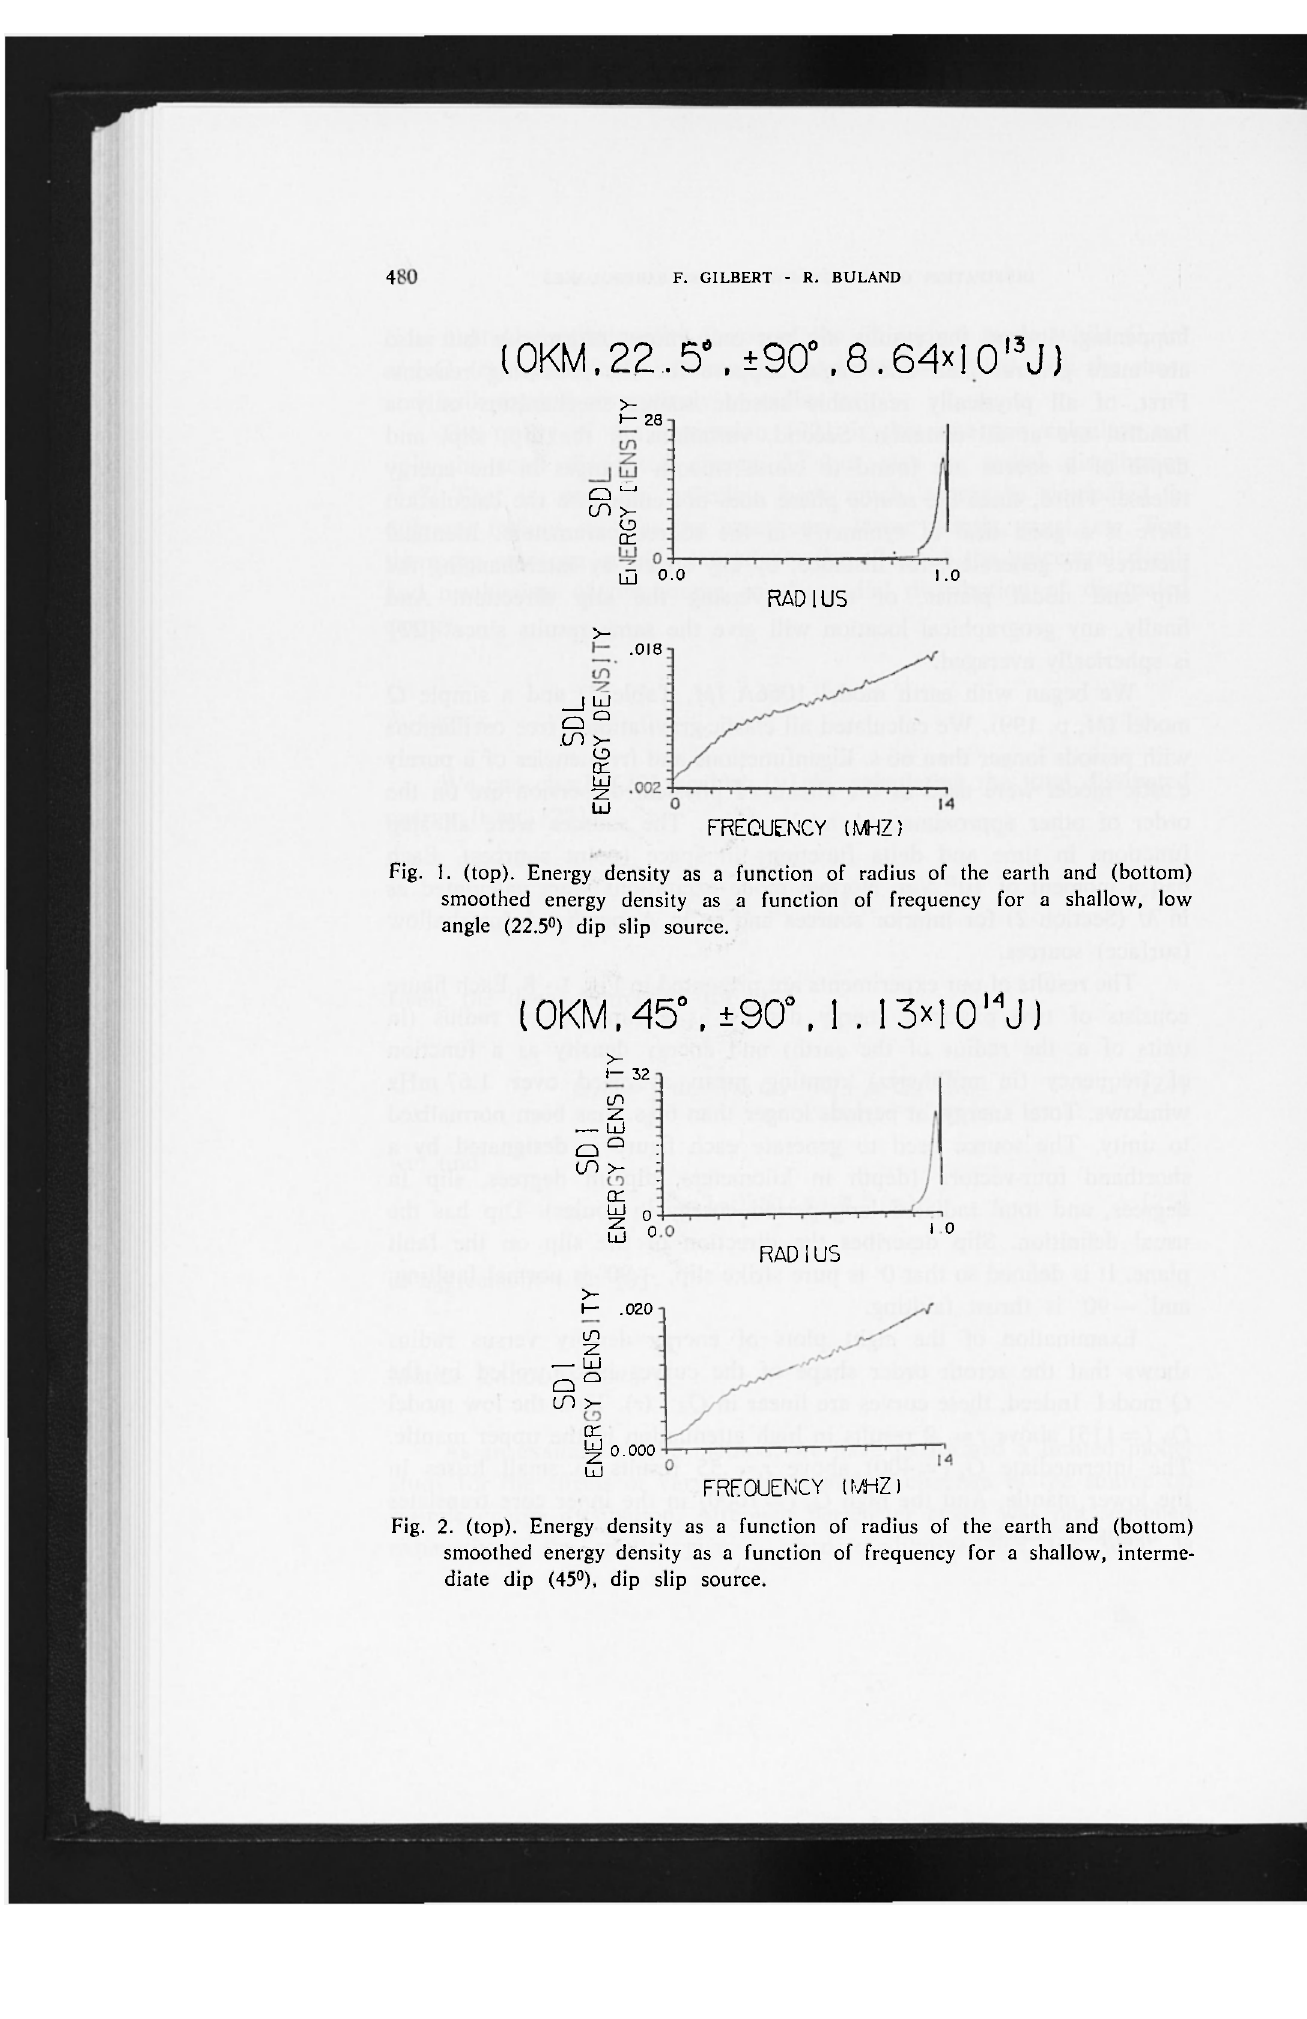
Fig. 1. (top). Energy density as a function of radius of the earth and (bottom) smoothed energy density as a function of frequency for a shallow, low angle (22.5°) dip slip source.